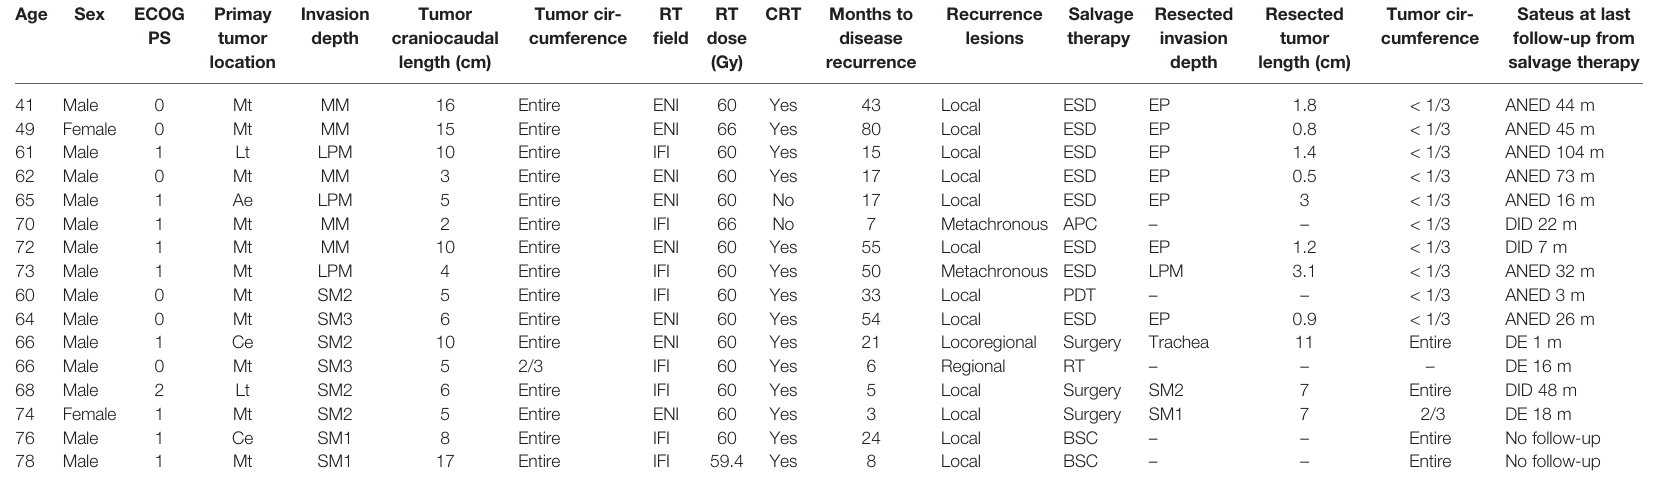
TABLE 3 | Summary of recurrent